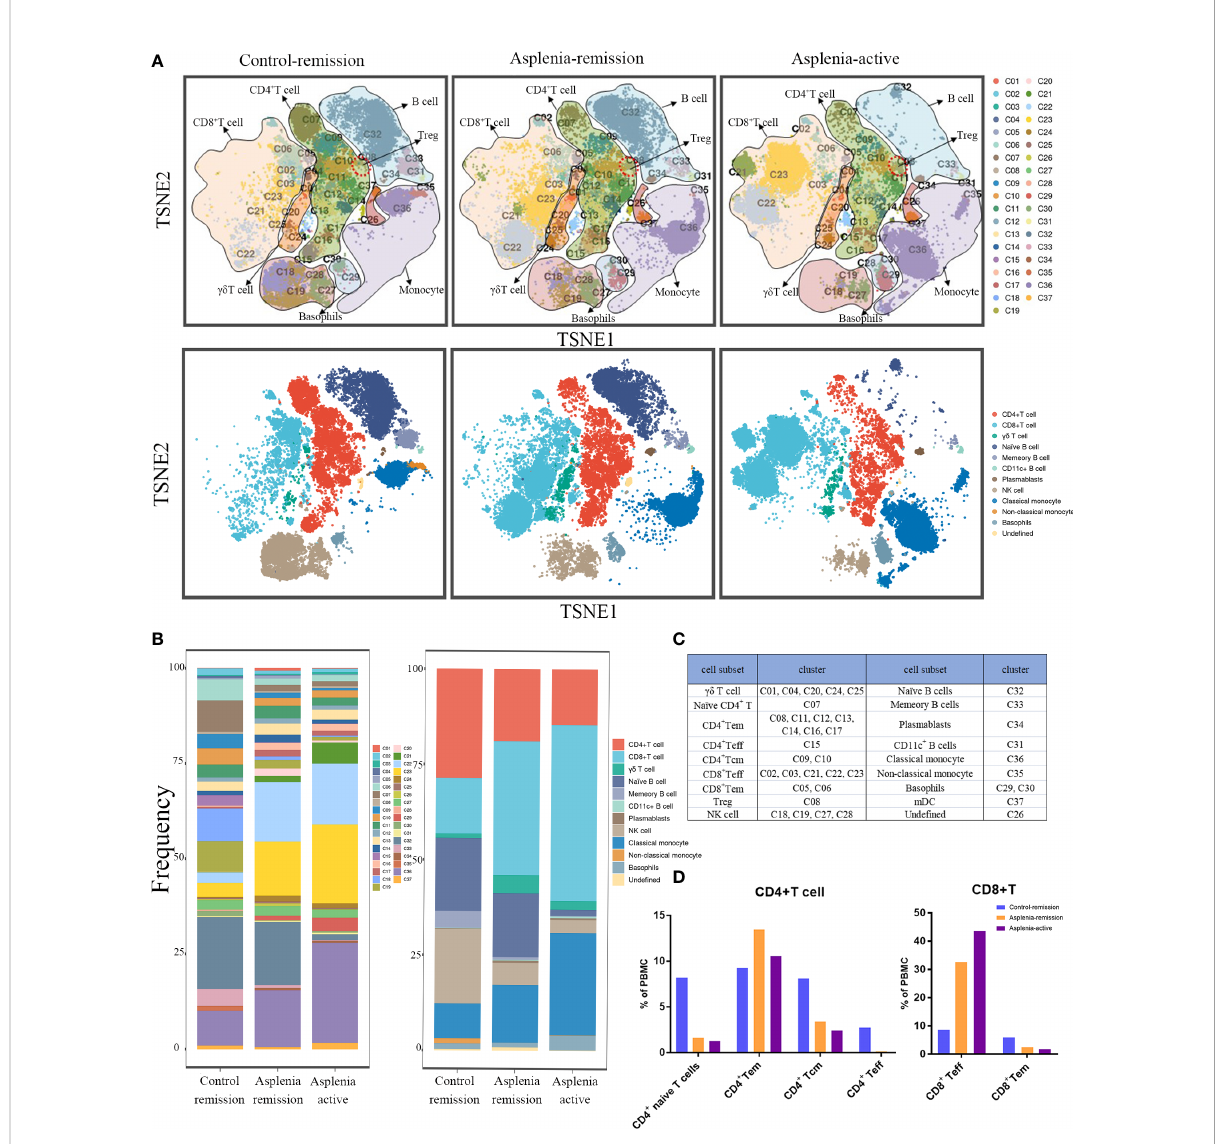
FIGURE 2 Single-cell mapping of peripheral blood mononuclear cells showed the signi fi cant differences of immune cell subsets among the control patient in remission and the asplenic patient in remission or active stage of CD. (A) Mass cytometric analysis and mapping of PBMC from the control patient in remission (left), the asplenic patient in remission (medial) and the asplenic patient in active stage of CD (right) using Cytometry by Time Of Flight (CyTOF) mass spectroscopy, t-distributed stochastic neighbor embedding (t-SNE) and clustering algorithms. (Upper panel: mapping of PBMC into 37 clusters based on differences in cell surface marker expression; lower panel: depicting differences in the distribution of cell subsets in PBMC based on 37 clusters.) (B) Bar graphs showing the difference in frequency of each cluster (left panel) or cell subset (right panel) across different samples. (C) Annotation of the immune cell subsets based on different clusters. (D) Differences in the frequency of each subset of CD4 + T cells and CD8 + T cells among the different samples. (Tem, effector memory T cells; Tcm, central memory T cells; Teff, effector T